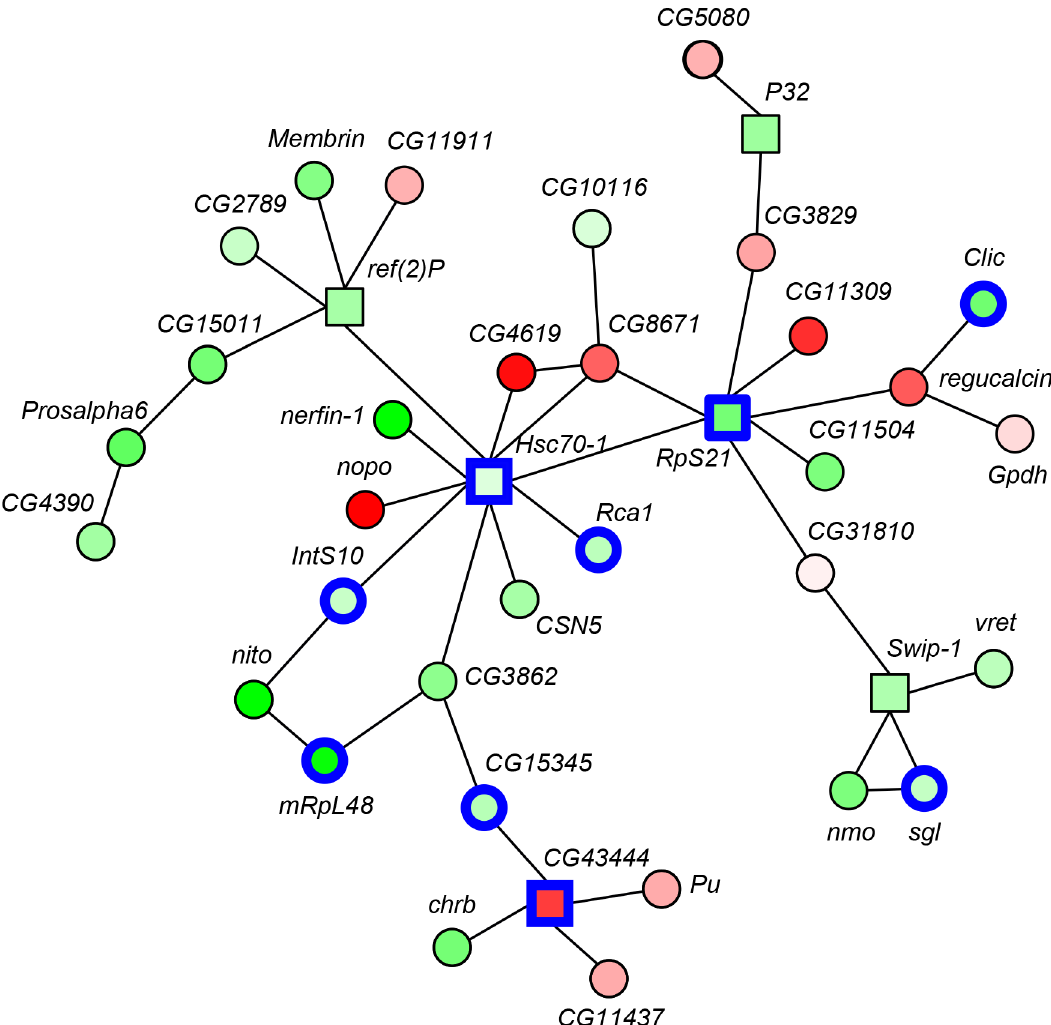
Fig 3. A shock avoidance-associated gene network. Each of the 38 nodes in the network represents a gene associated with shock avoidance in terms of expression level (see S6 Table for a list). Each edge indicates a pair-wise physical interaction between the proteins encoded by the respective genes, based on independent empirical evidence. Shades of green mean that the higher the respective gene ’ s expression level, the stronger the shock avoidance was. Shades of red mean the converse, i.e., the higher the expression level the weaker the shock avoidance. The darker the shading, the greater the estimated effect of expression level on shock avoidance was. Circles represent genes with a statistically strong association with shock avoidance resulting in a positive network score. Potential functionally related genes with less significant association (negative scores; represented by squares) were included to form connections between the more strongly associated genes. Genes implicated in bristle-function are haloed